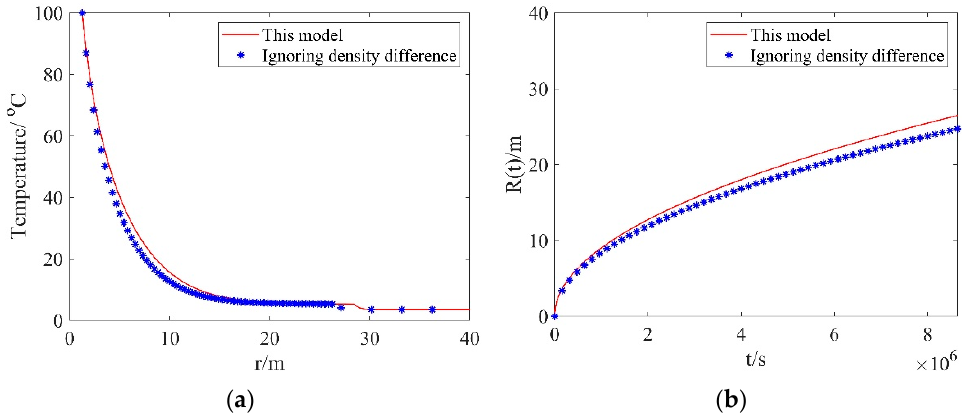
Figure 2. Comparisons of results from this model and the model ignoring density difference: ( a ) the temperature distributions; ( b ) dissociation distances.